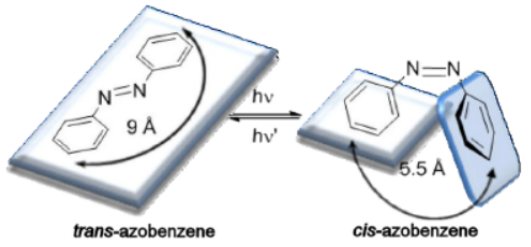
Figure 1. Photoisomerization process of azobenzene [10].